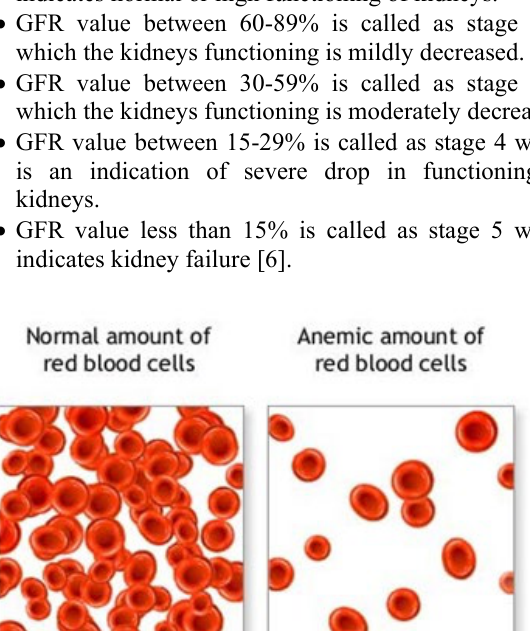
Figure 1. Different complications of diabetes